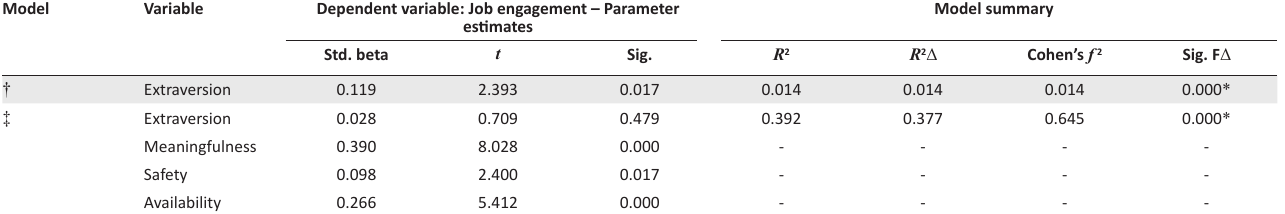
TABLE 6 : Hierarchical multiple regression analyses testing extraversion and psychological conditions constructs in the prediction of job engagement. Model